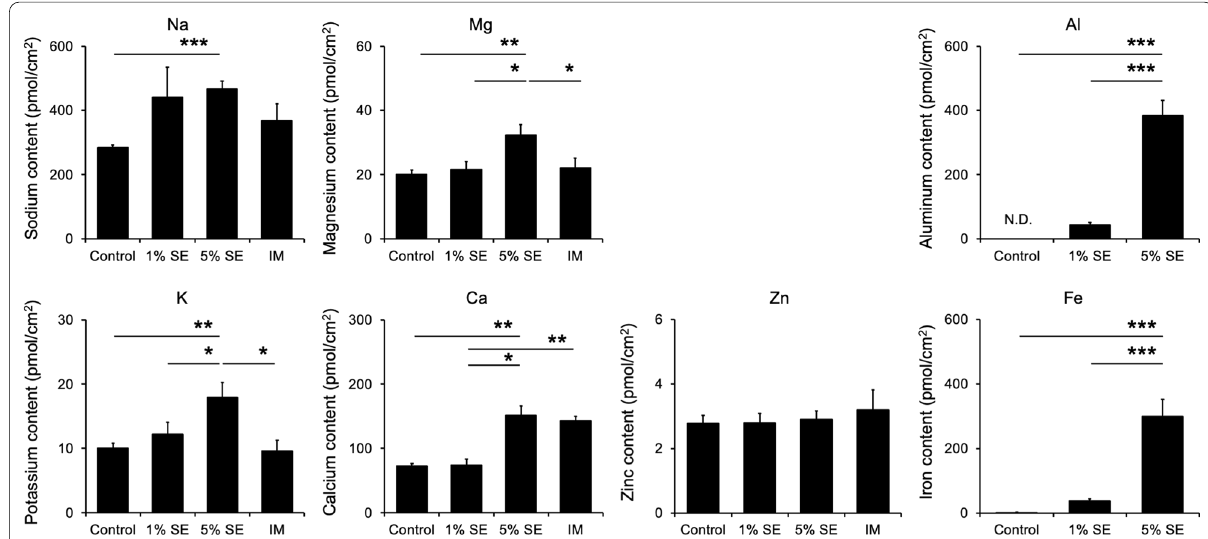
Fig. 2 Ion content in three-dimensional cultured human epidermis after application of SE. Three-dimensional cultured human epidermis was treated with SE or IM for 8 days. Data are expressed as mean S.D. of three independent experiments. * p < 0.05, ** p < 0.01, and *** p < 0.001. ± Statistical significance was evaluated using Tukey’s post hoc multiple comparison test. N.D. not detected